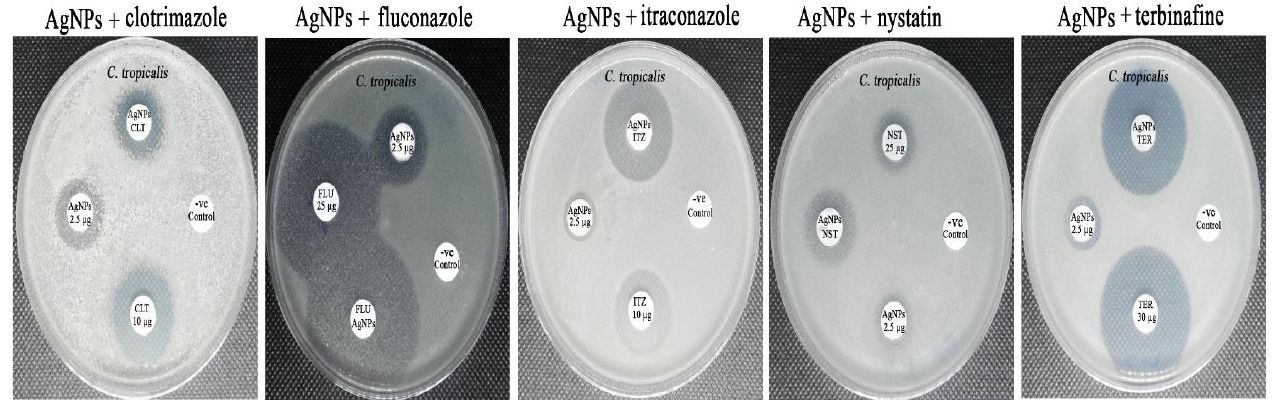
Figure 11. Synergistic patterns of biogenic AgNPs with different antifungal agents against C. tropi- calis strain.